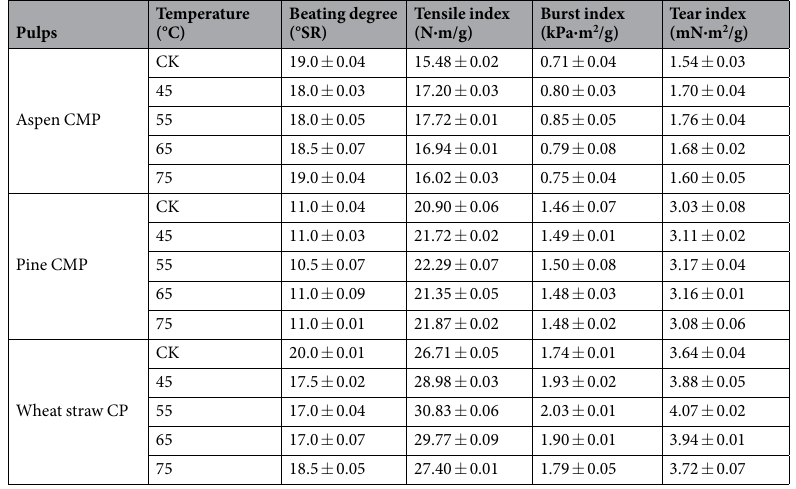
Table 3. Effect of different temperature during enzymatic treatment on pulp properties. * The pulps were treated at pH 7.0, and other conditions were same as Table 2.